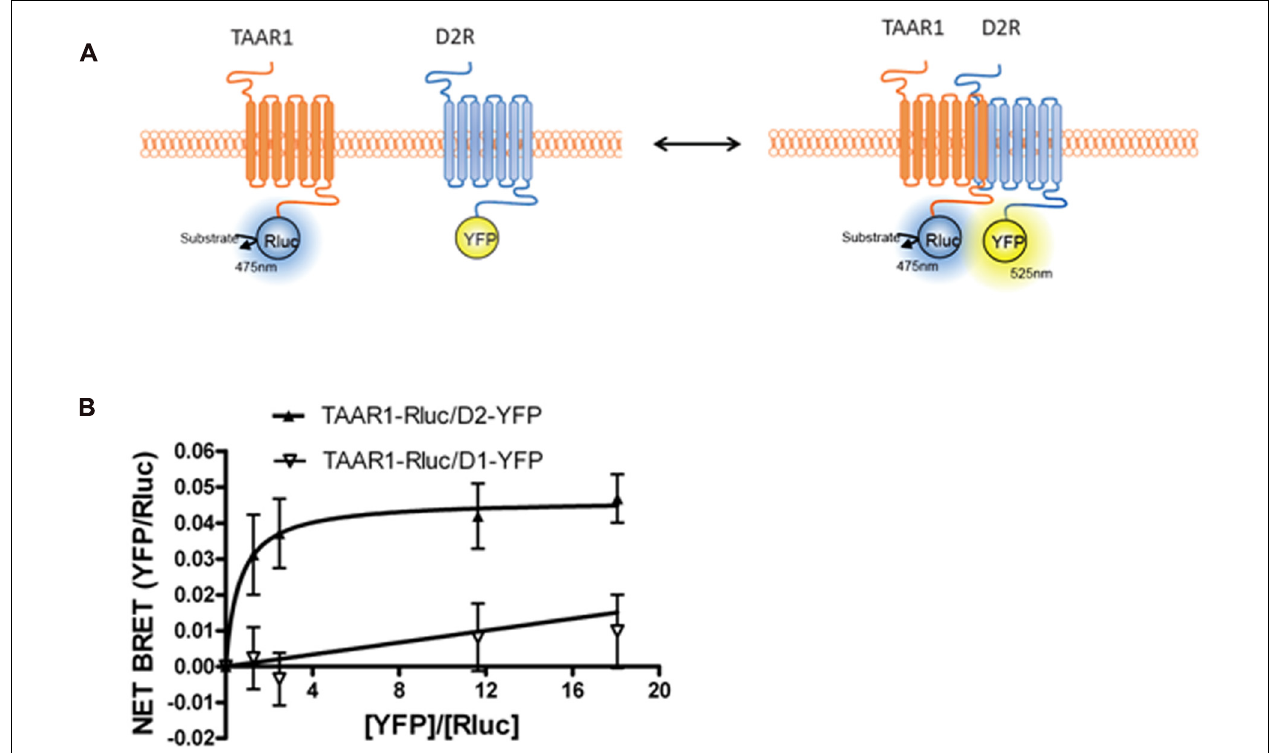
20 min after the addition of the substrate, coelenterazine h.To test specificity of BRET signal betweenTAAR1 and D2R, BRET was also measured betweenTAAR1–Rluc and increasing amount of D1R–YFP.The hyperbolic shape of the curve indicates thatTAAR1–Rluc and D2R–YFP form a constitutive heterodimer when co-expressed in the same cells. A linear increase in the BRET signal is observed betweenTAAR1–Rluc and D1–YFP indicating a non-specific, bystander BRET between these